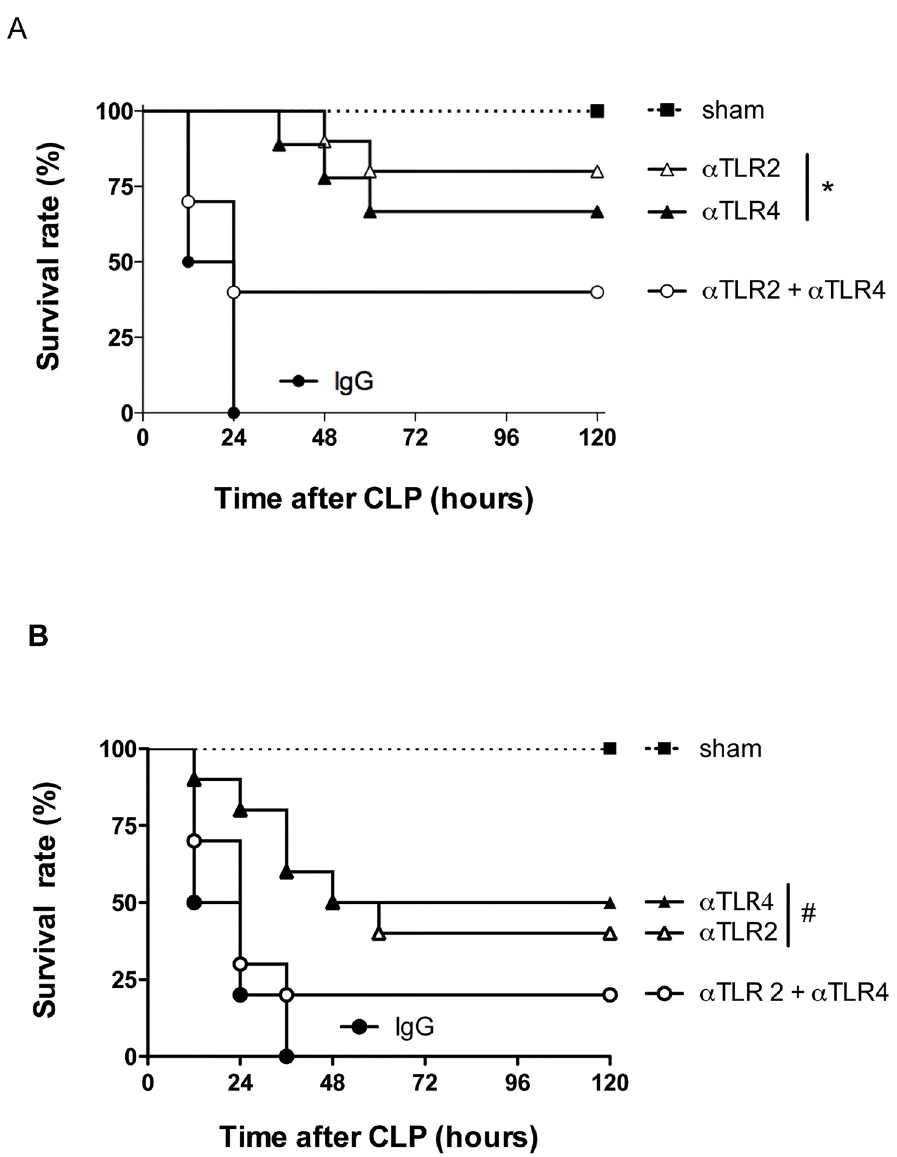
Fig 1. Blockade of either TLR2 or TLR4 improves survival during polymicrobial sepsis. The survival rate was analyzed following CLP procedure comparing the effect of the treatment with isolated or combined anti-TLR2 and anti-TLR4 antibodies. The treatments were performed 45 minutes before (A) or 3 hours after (B) the CLP procedure. The combined treatment with both anti-TLR2 and anti-TLR4 showed a similar survival curve compared to the negative control isotype IgG treated-group (CLP) * P < 0.001 between Individual antibody treatments and negative control (IgG). # p < 0.05 between individual antibody treatments and negative control (IgG) Antibody dose (1 mg/animal). (n =